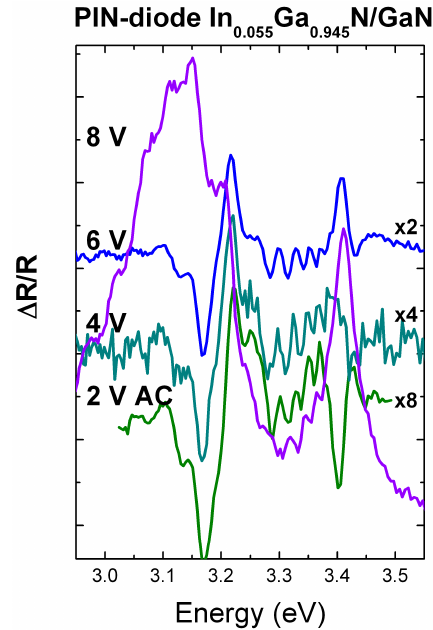
Figure 6. ER spectra of PIN-diodes based on In 0.055 Ga 0.945 N / GaN DHS in dependence of AC modulation voltage.